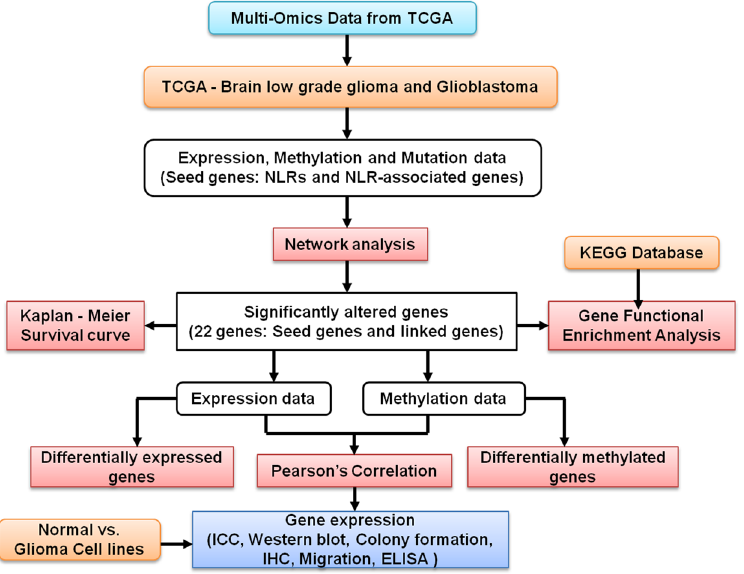
Figure 1. Schematic workflow of multi-dimensional investigation exploring the role of nucleotide-binding domain and Leucine rich-repeat containing receptors in glioma